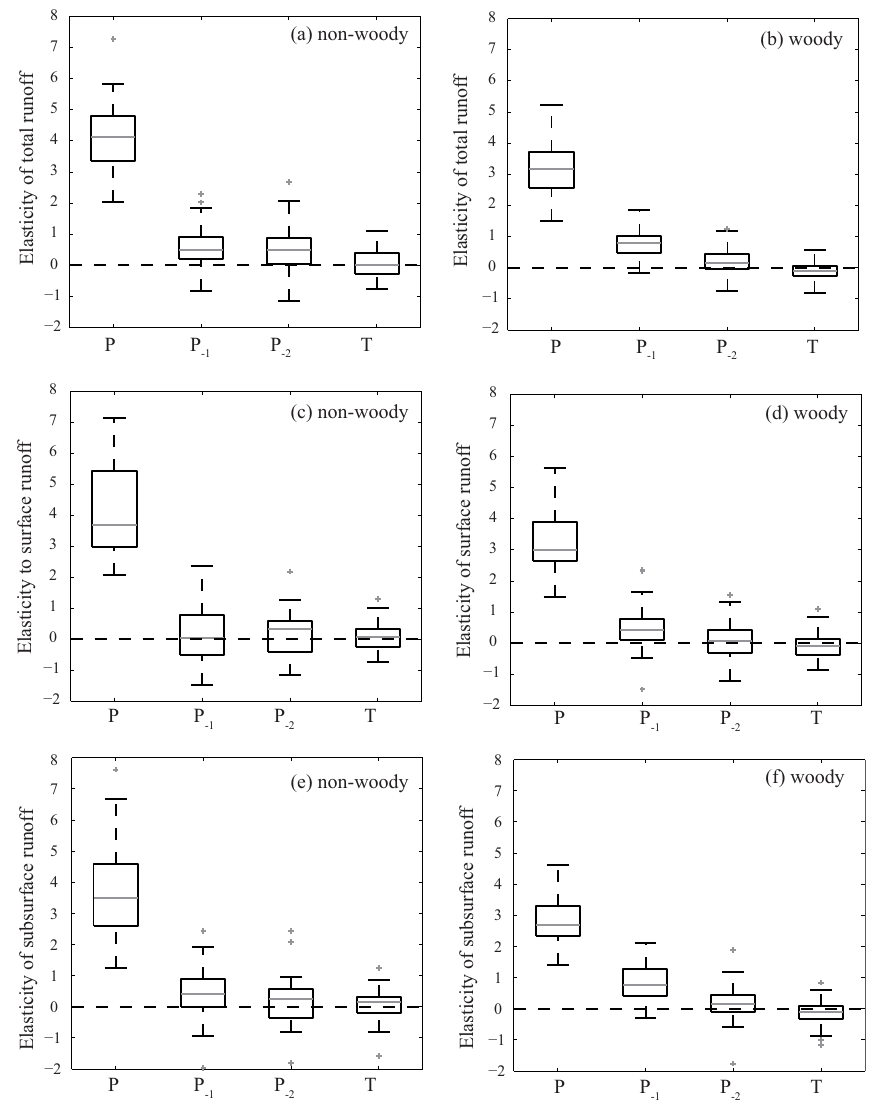
Fig. 8. The quantile map of climate elasticity parameters of annual total runoff for (a) 60 non-woody vegetation dominated catchments (with E 0 /P ≥ 2.0) and (b) 107 woody vegetation dominated catchments (with E 0 /P < 2.0), annual surface runoff for (c) 36 non-woody vegetation dominated catchments and (d) 76 woody vegetation dominated catchments, subsurface runoff for (e) 29 non-woody vegetation dominated catchments and (f) 67 woody vegetation dominated catchments. The upper black line is the maximum whisker (the length of whisker is 1.5), the lower black line is the minimum whisker, the upper quartile is the 75th percentile, the lower quartile is the 25th percentile, the grey line is the median value, the grey cross is the point out of the whiskers. Note that P represents current year’s precipitation, P − 1 represents last year’s precipitation, P − 2 represents the year before last year’s precipitation and T represents current year’s temperature.